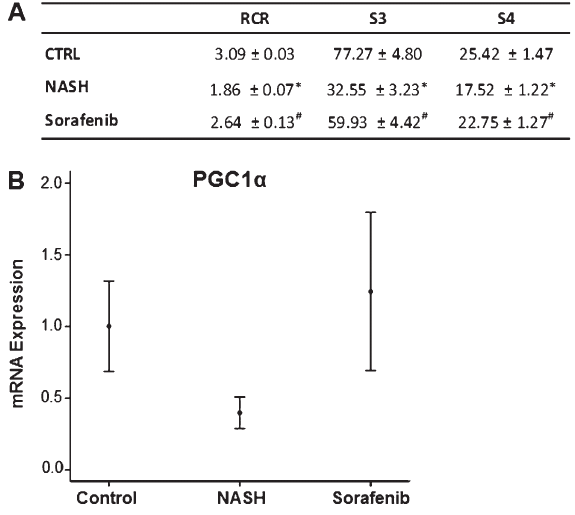
Figure 4. A , Stages of mitochondrial respiration in liver homogenates of control (CTRL; n=4), nonalcoholic